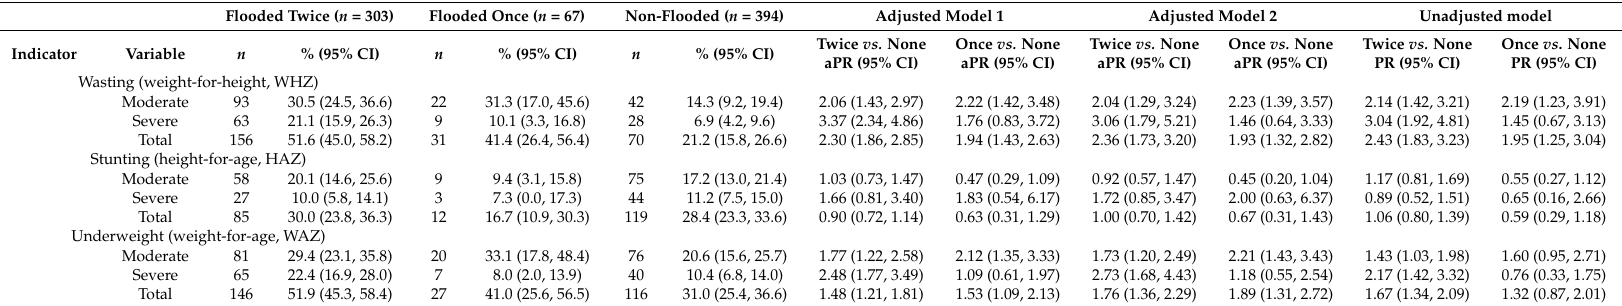
aPR, adjusted prevalence ratio; PR, unadjusted prevalence ratio. Model 1 adjusted by confounders (see the detailed list of confounders by indicator in Table A1). Model 2 adjusted by confounders and population characteristics which differ across flooded and non-flooded communities (Table